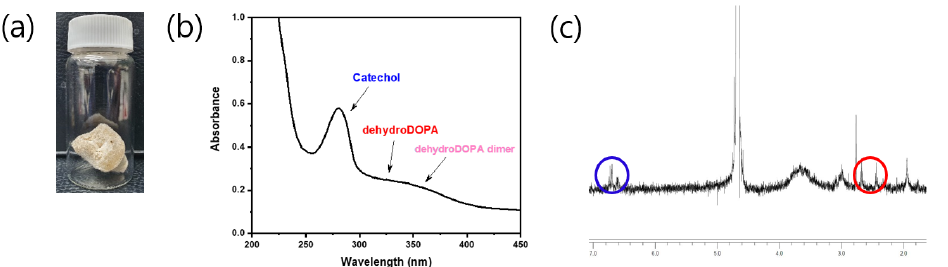
Figure 3. Qualitative analysis of Cat-Chit: ( a ) photograph of the product; ( b ) UV–vis spectrum; ( c ) 1 H-NMR.